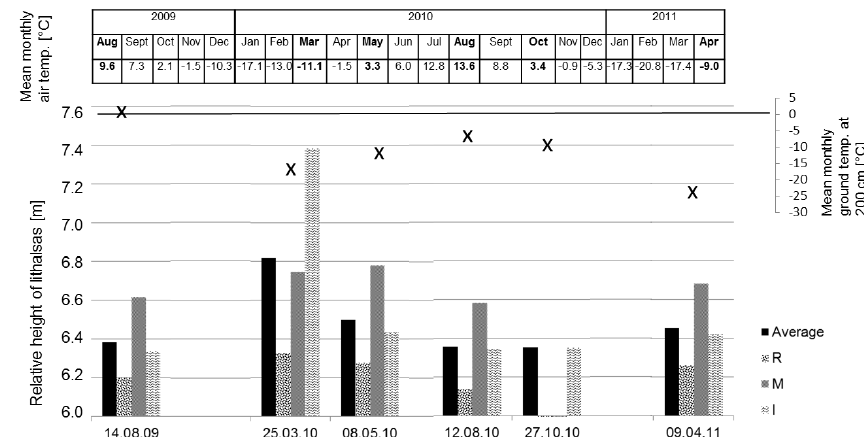
Figure 4. Heights of the three lithalsas (grey bars) and their average heights (black bars), relative to the base station, on the six measuring dates spread over a 20-month period. The heights represent the average of heights from all measurement points within each individual lithalsa. The records are accurate to within a few centimeters. The lithalsas were not covered by snow during the measurements. The temperatures at the top are the mean monthly air temperatures of the specific year provided (CEN, 2013). Temperatures written in bold are for the month with d-GPS